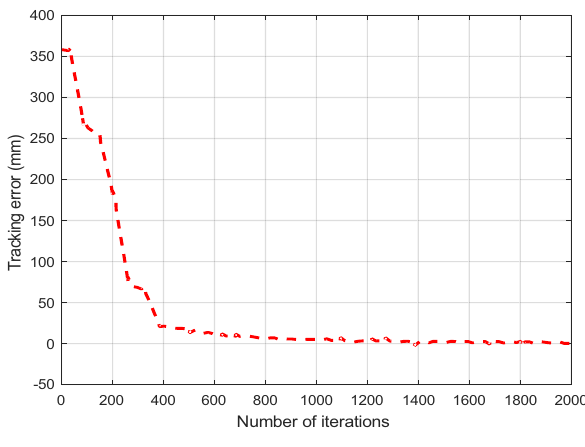
Figure 2: Number of